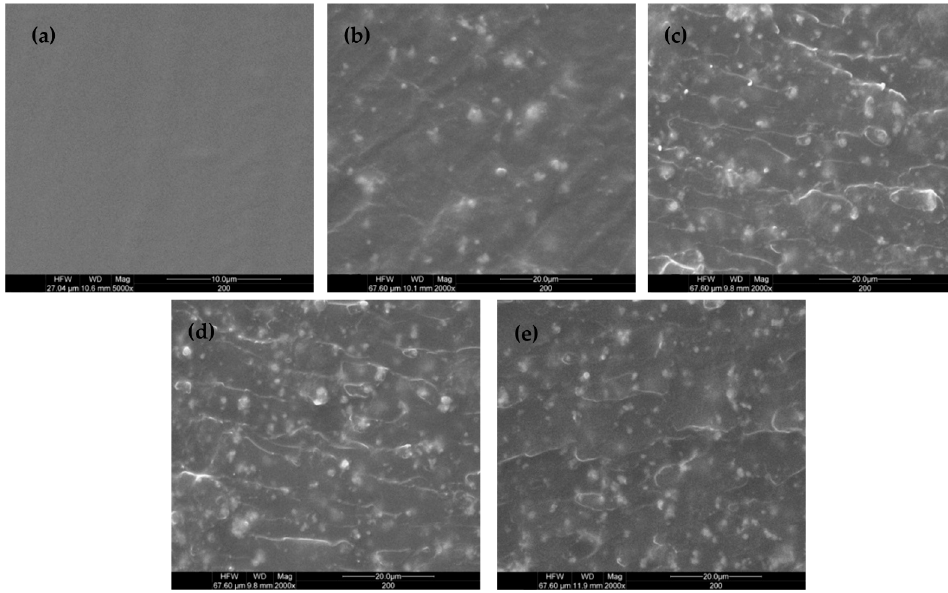
Figure 5. Cross-sectional SEM images of the nanocomposites with different weight fractions. ( a ) 0 wt %; ( b ) 7 wt %; ( c ) 15 wt %; ( d ) 25 wt %; and ( e ) 40 wt %. All bars are 20 μ m.